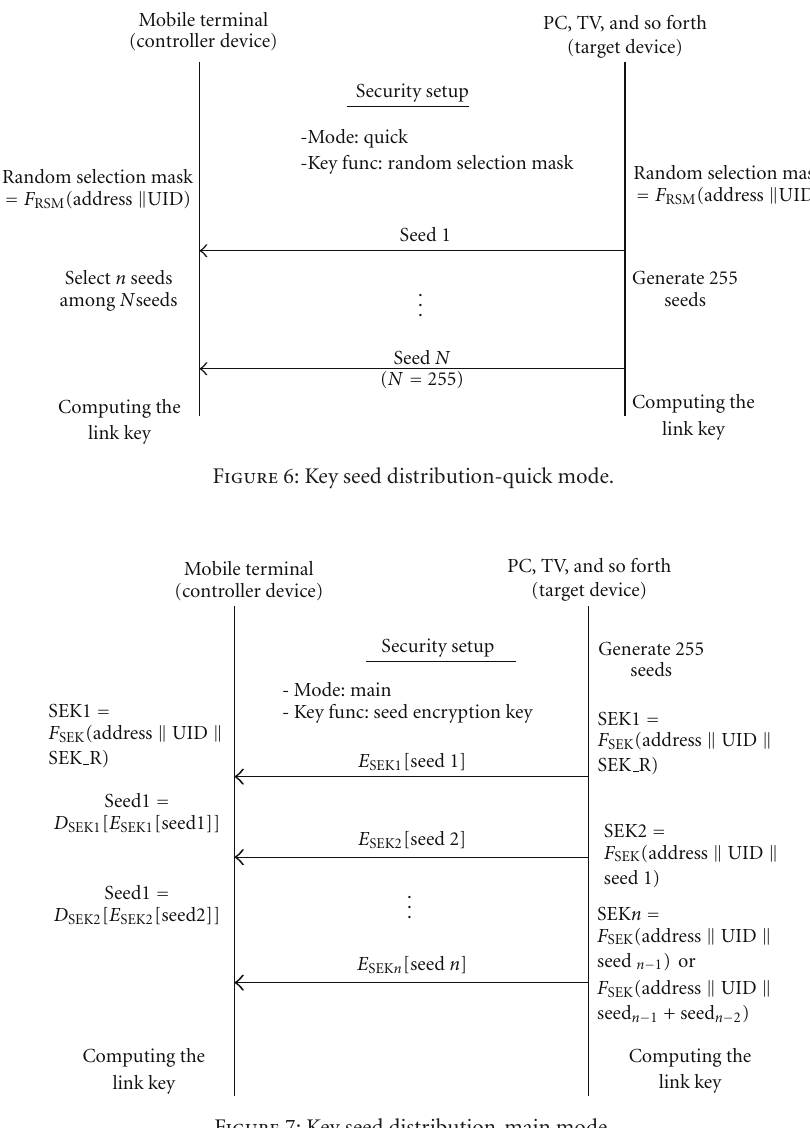
Figure 7: Key seed distribution-main